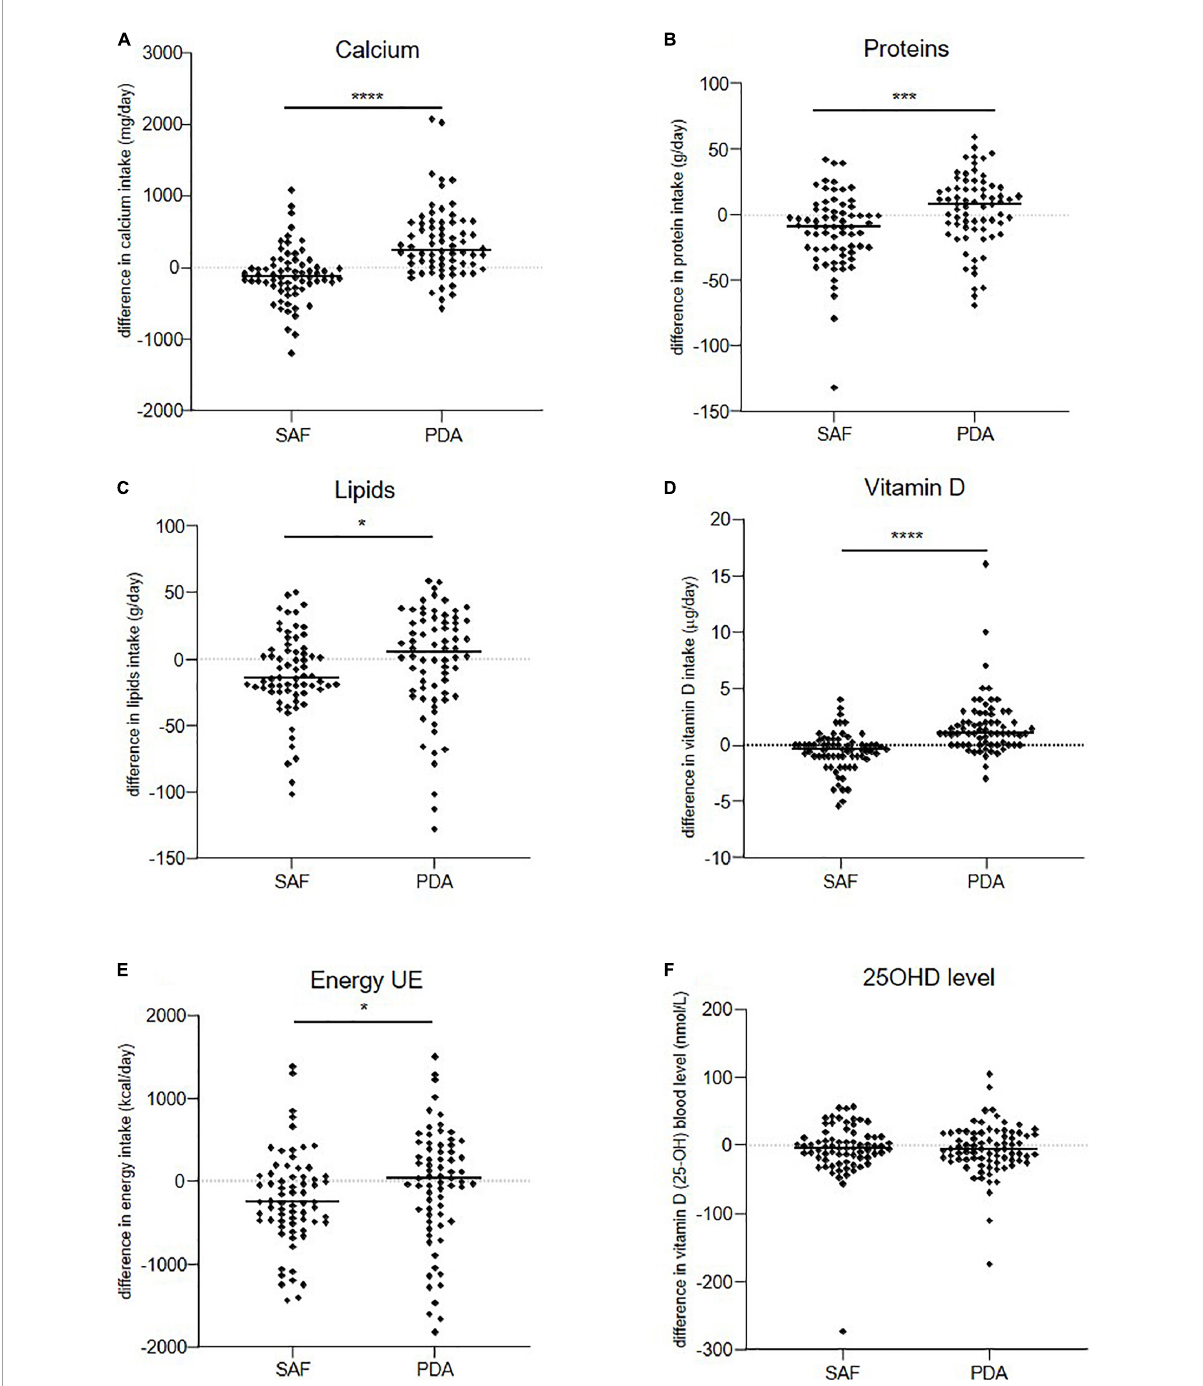
FIGURE2 Evolution over 6 months of patients’ daily intakes. (A) Calcium, (B) proteins, (C) lipids, (D) vitamin D, (E) energy, and (F) level of serum 25OHD in SAF and PDA groups. Means are shown as horizontal bars. Statistical significance was determined using the Wilcoxon–Mann–Whitney